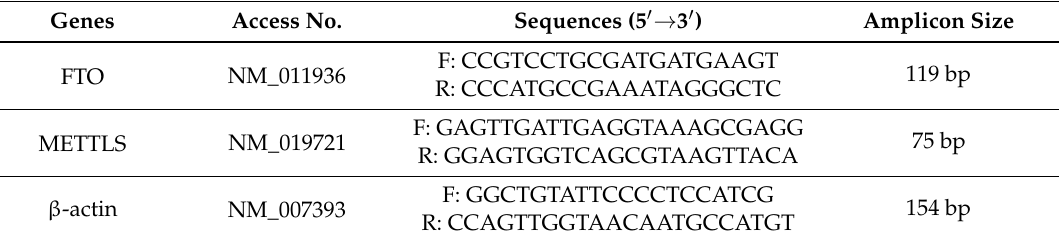
Table 2. Primers for real-time polymerase chain reaction (PCR). Genes Access